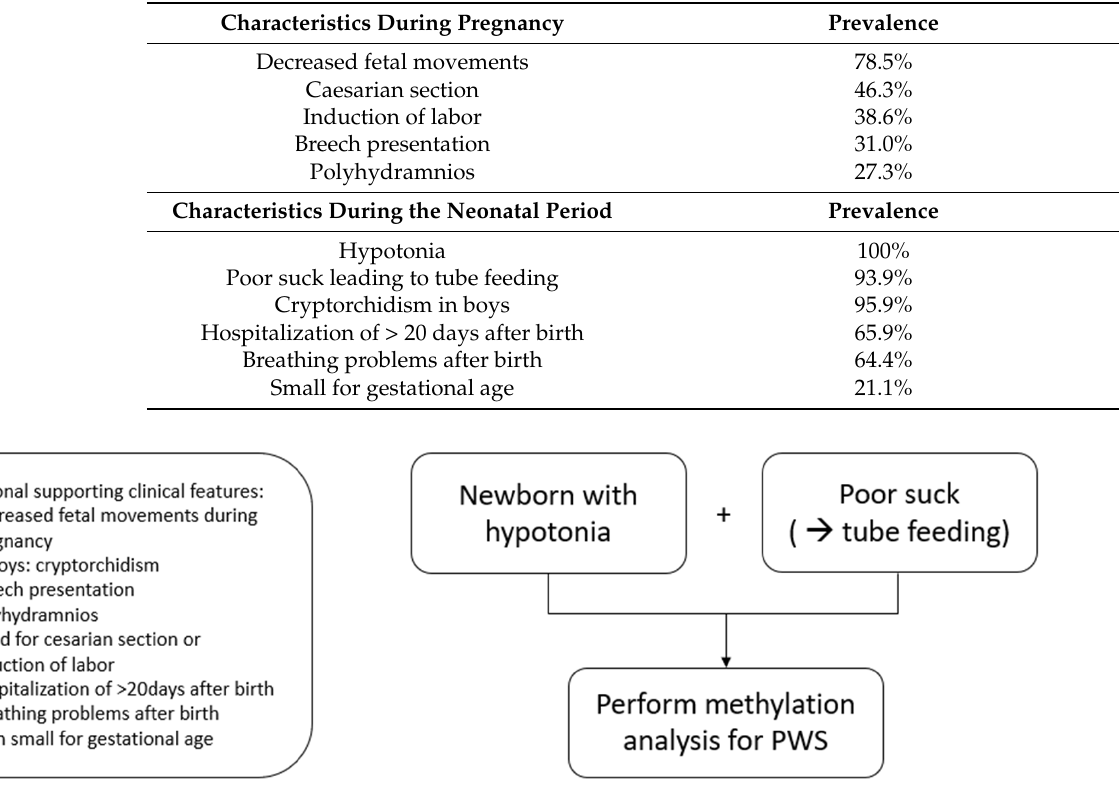
Figure 1. Flowchart for genetic testing and diagnosis of Figure 1 . Flowchart for genetic testing and diagnosis of PWS. Table 4. Characteristics of Prader-Willi Syndrome during pregnancy and neonatal period.